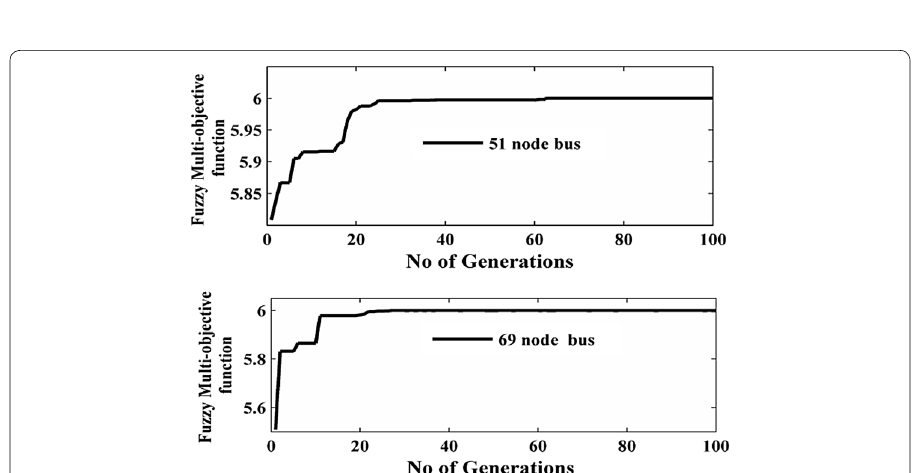
Fig. 10 Convergence characteristics with proposed fuzzy GA methodology for 51- and 69-node